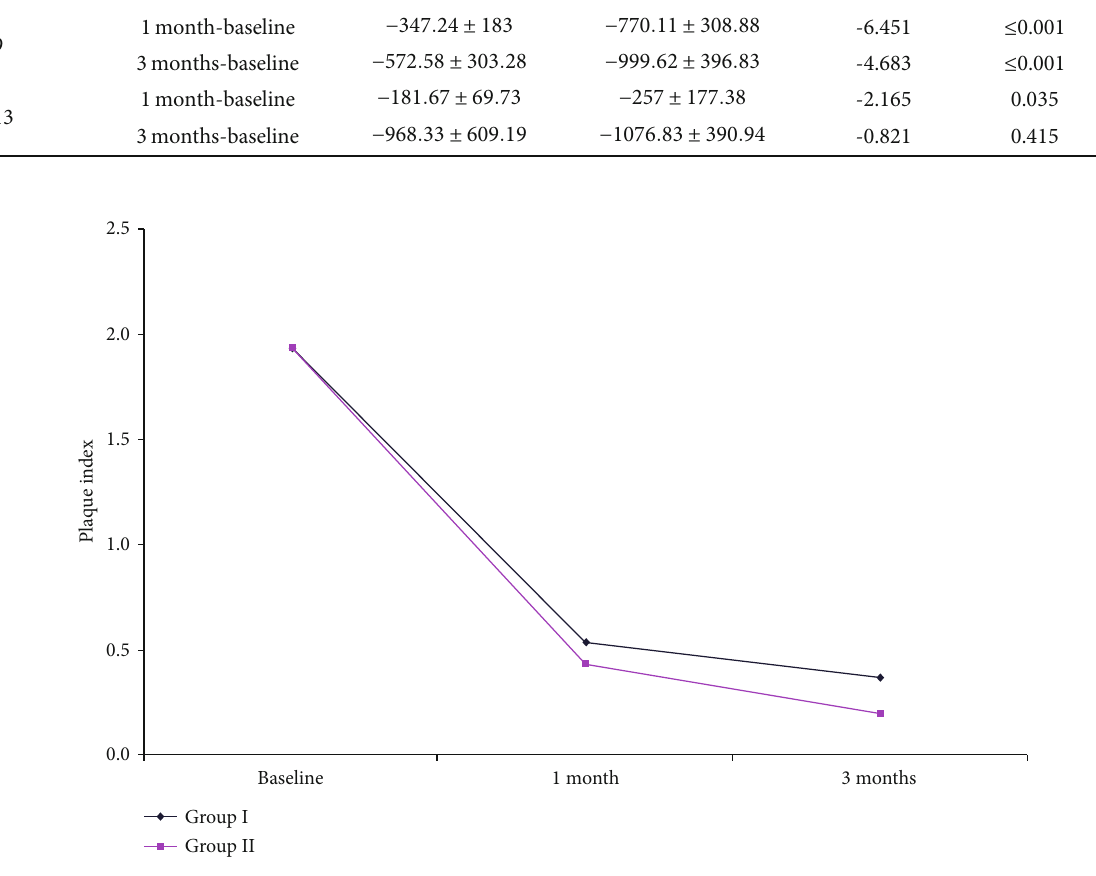
Figure 2: The mean PI changes in Group I and Group